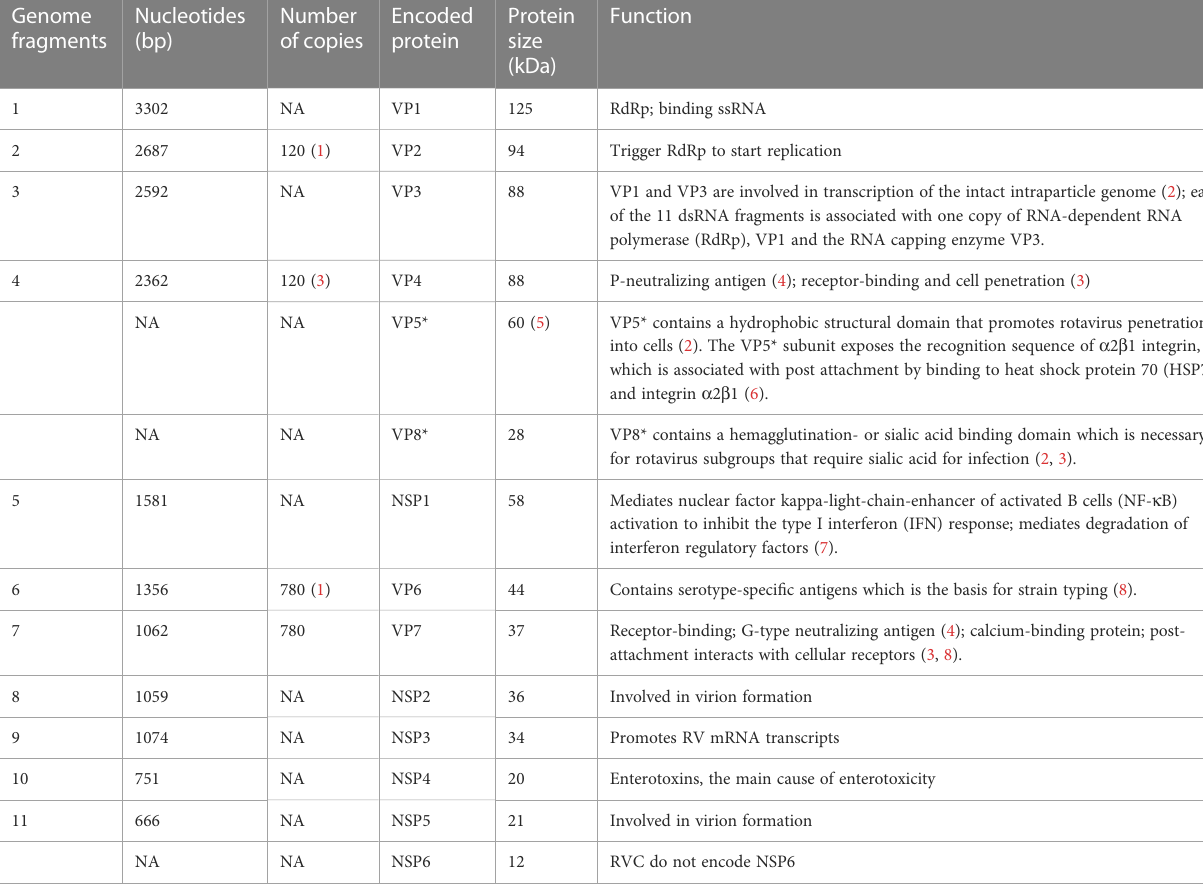
TABLE 1 The rotavirus genome and its encoded viral proteins and functions. Genome fragments